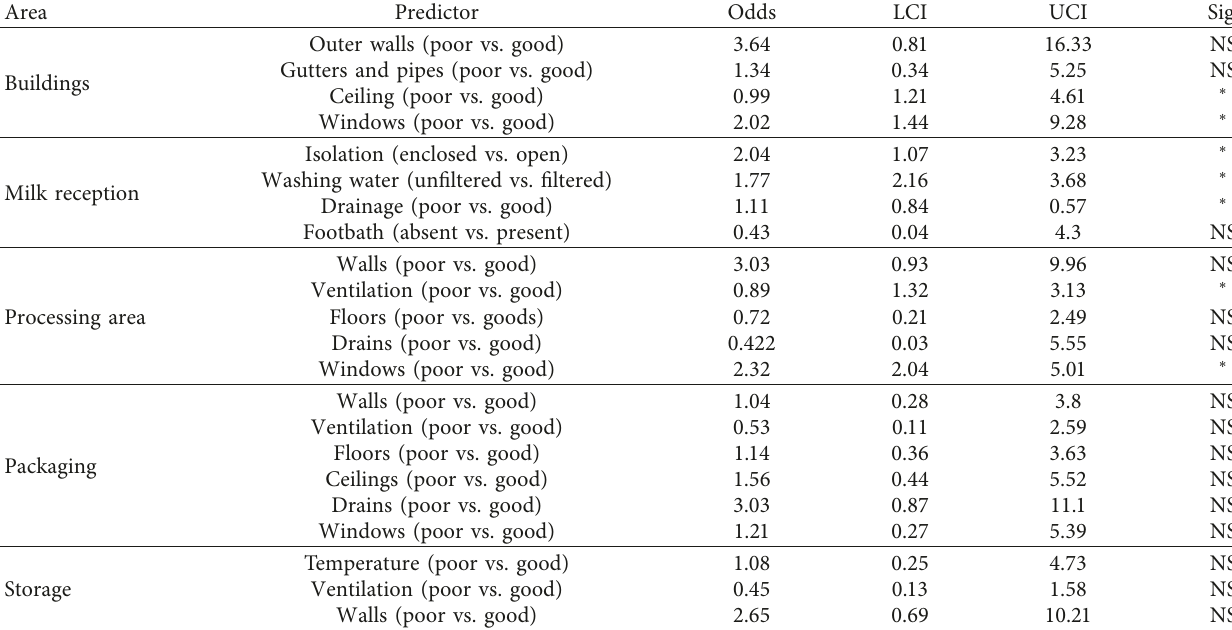
Table 3: Odds ratio estimate and lower (LCI) and upper confidence interval (UCI) of cultured buttermilk from processors with features which are not in adequate conditions having E. coli .